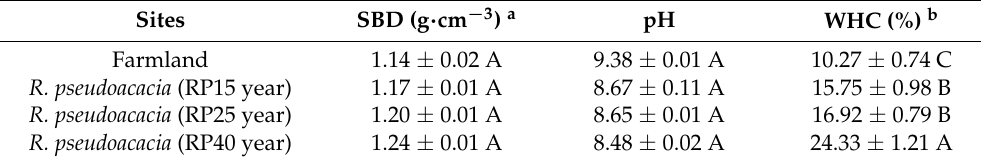
Table 2. Soil properties after afforestation.